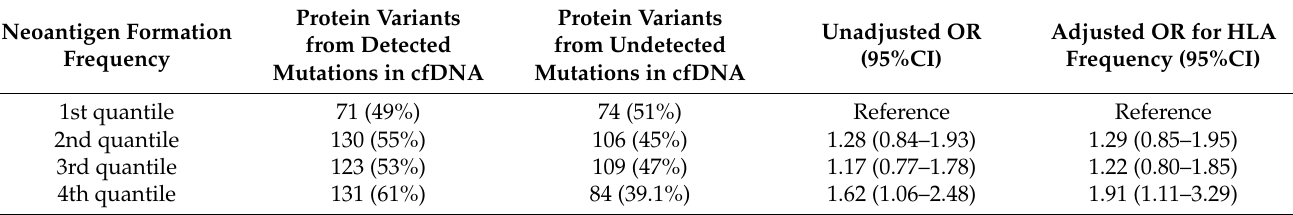
Table 2. Odds of detecting TP53 mutations in cfDNA relevant to the frequency of neoantigen formations resulted from mutations.